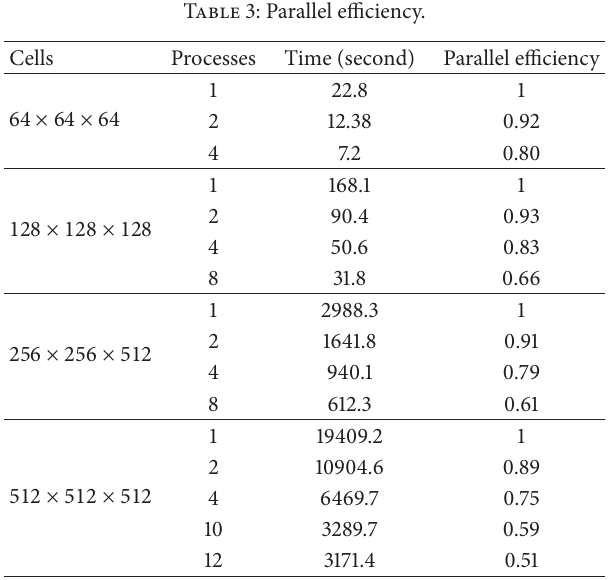
Table 3: Parallel efficiency.